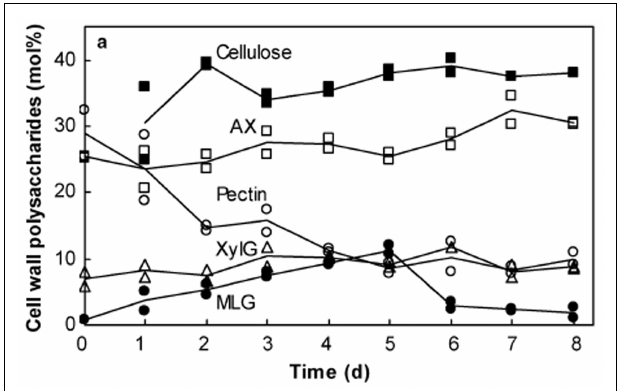
FIGURE 2 | Changes in cell wall composition during the development of barley coleoptiles. Compositions were deduced from data obtained by alditol acetate, methylation and acetic–nitric acid analyses. Changes in cellulose (filled square), arabinoxylan (AX, open square), pectic polysaccharides (pectin, open circle), xyloglucan (XylG, triangle), and (1,3;1,4)- β -glucan (MLG, filled circle) are shown. Reproduced with permission from Gibeaut etal.